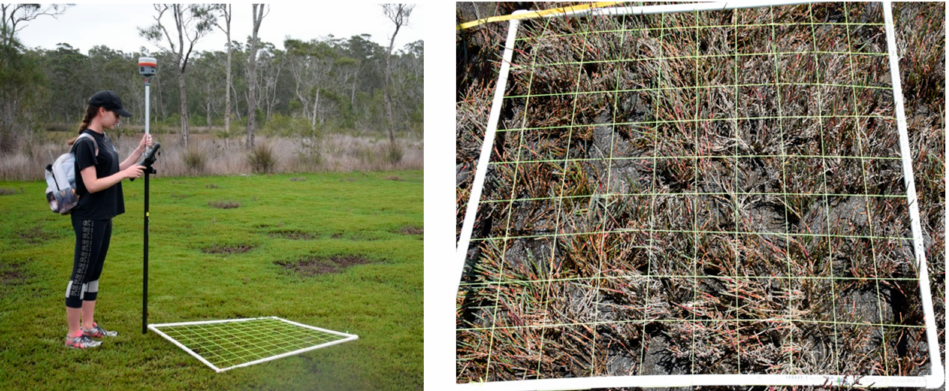
Figure 2. A Trimble R10 real-time kinematic GPS ( left ) was used to measure the precise location of each quadrat. Each 1 m 2 quadrat was divided into 10 cm 2 sections and photographed to aid in species identification e.g., ( right ) patchy Sarcocornia quinqueflora